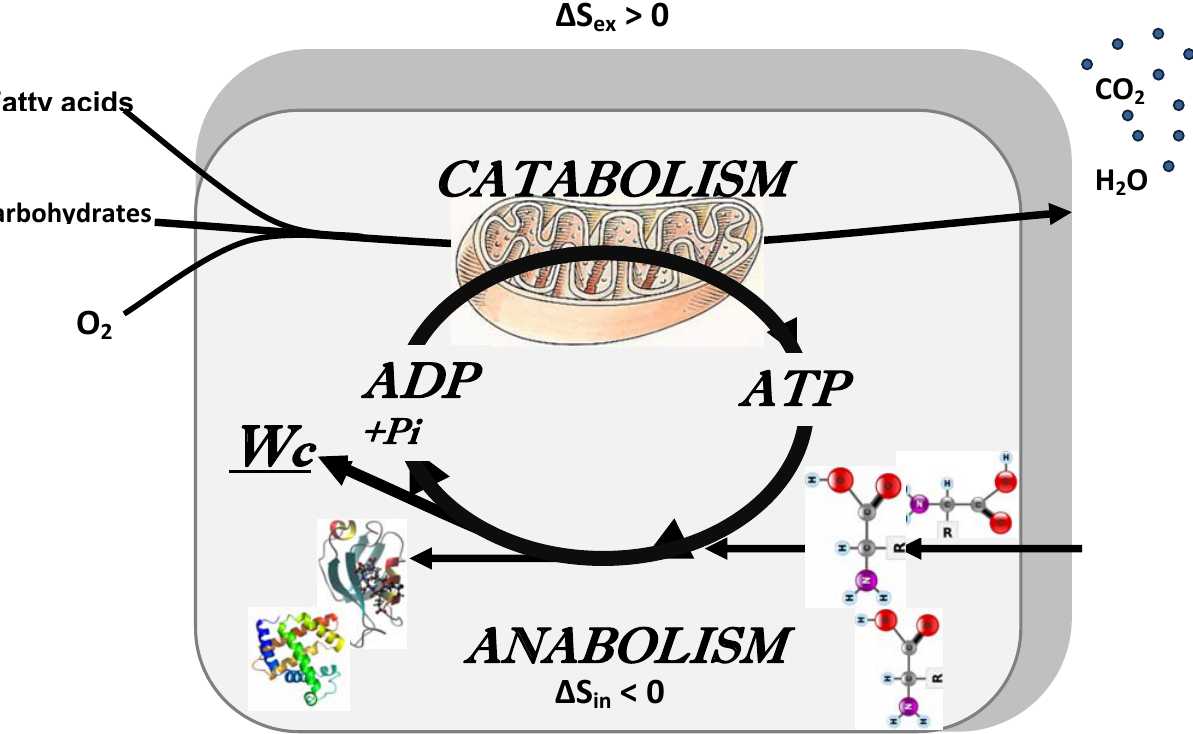
Figure 3. General scheme of cellular metabolism. A cell is a thermodynamically open system, in accordance with the Schrödinger’s principle of negentropy extraction. Increasing the entropy in extracellular medium, and decreasing it in the cell via metabolism is necessary for maintenance of the structural organization of both biopolymers as proteins, DNA and RNA, and also maintenance of the fine structural organization of the cell for effectively running compartmentalised metabolic processes. In this way, the cell can live in agreement with the thermodynamic laws (see the text). The Scheme shows the central role of bioenergetic processes in the cellular life by coupling catabolism with anabolism. Adapted from ref.